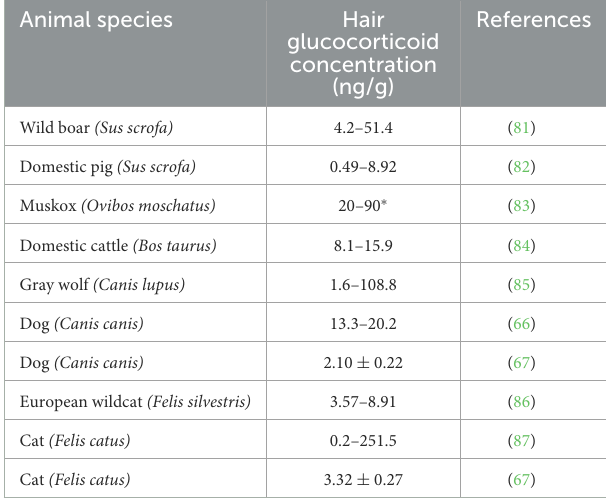
TABLE 2 Hair glucocorticoid concentrations in wild animals and related domestic animal species. Animal